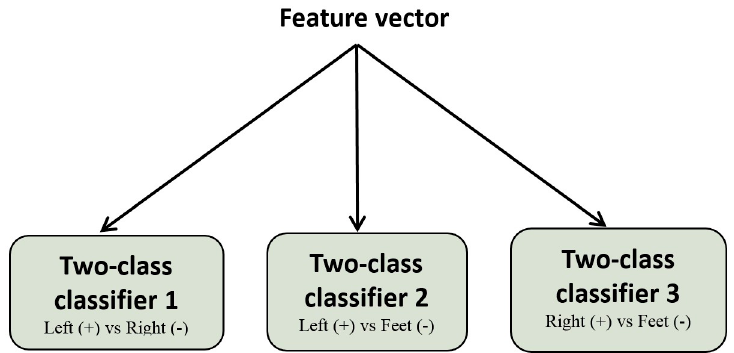
Figure 2. One-Against-One strategy based three-class SVM and LDA classifiers (multi-SVM, multi-LDA).